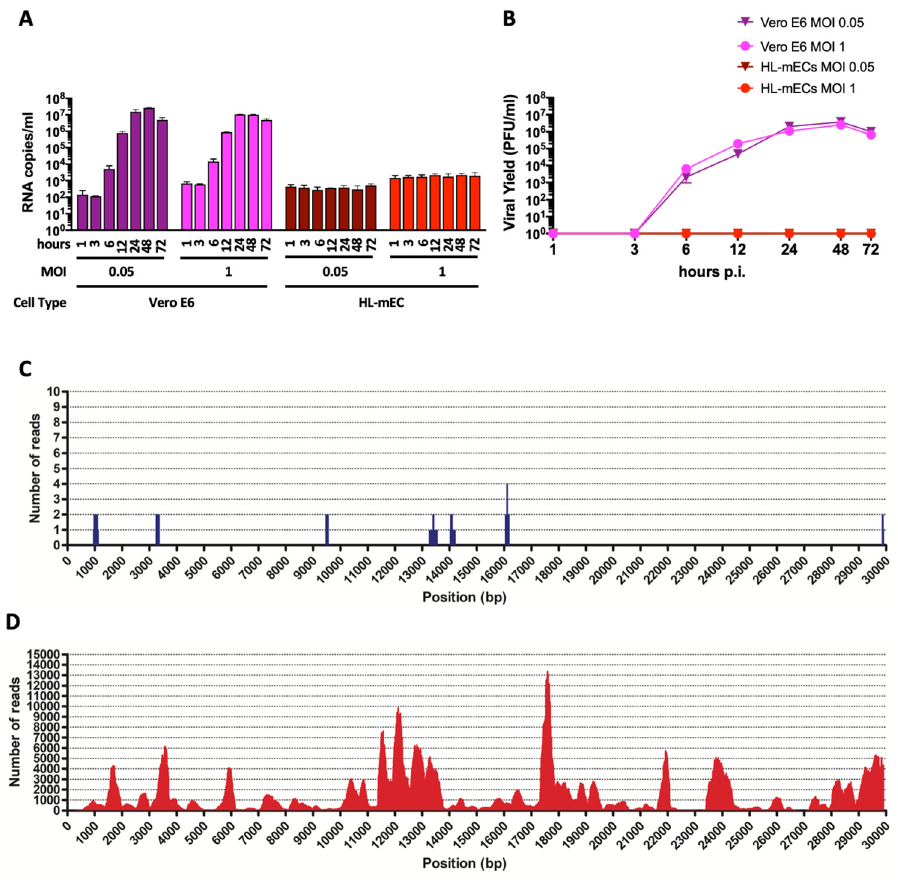
Figure 1. SARS-CoV-2 does not productively infect HL-mECs. ( A ) Vero E6 and HL-mECs were infected with SARS-CoV-2 at a MOI of 0.05 or 1. The graph shows SARS-CoV-2 genome quantitation in cell supernatants collected at 1, 3, 6, 12, 24, 48, and 72 h p.i. by qRT-PCR. Values represent the S gene copies/mL mean ± SD of a triplicate. ( B ) Supernatants were collected from Vero E6 and HL-mECs at 1, 3, 6, 12, 24, 48, and 72 h p.i. and infectious viral titers were determined by plaque assay. Data represent the average of three replicates from one experiment. ( C ) Deep sequencing analysis of SARS-CoV-2 viral progeny released from HL-mECs or ( D ) from Vero E6 cells at day 3 p.i. Whole-genome sequences of SARS-CoV-2 released in the supernatants were performed by metagenomic analyses. Obtained reads were mapped on the virus genome reference NC_045512.2 ( x -axis) for genome reconstruction; the y-axis shows the number of reads mapped at each nucleotide position.